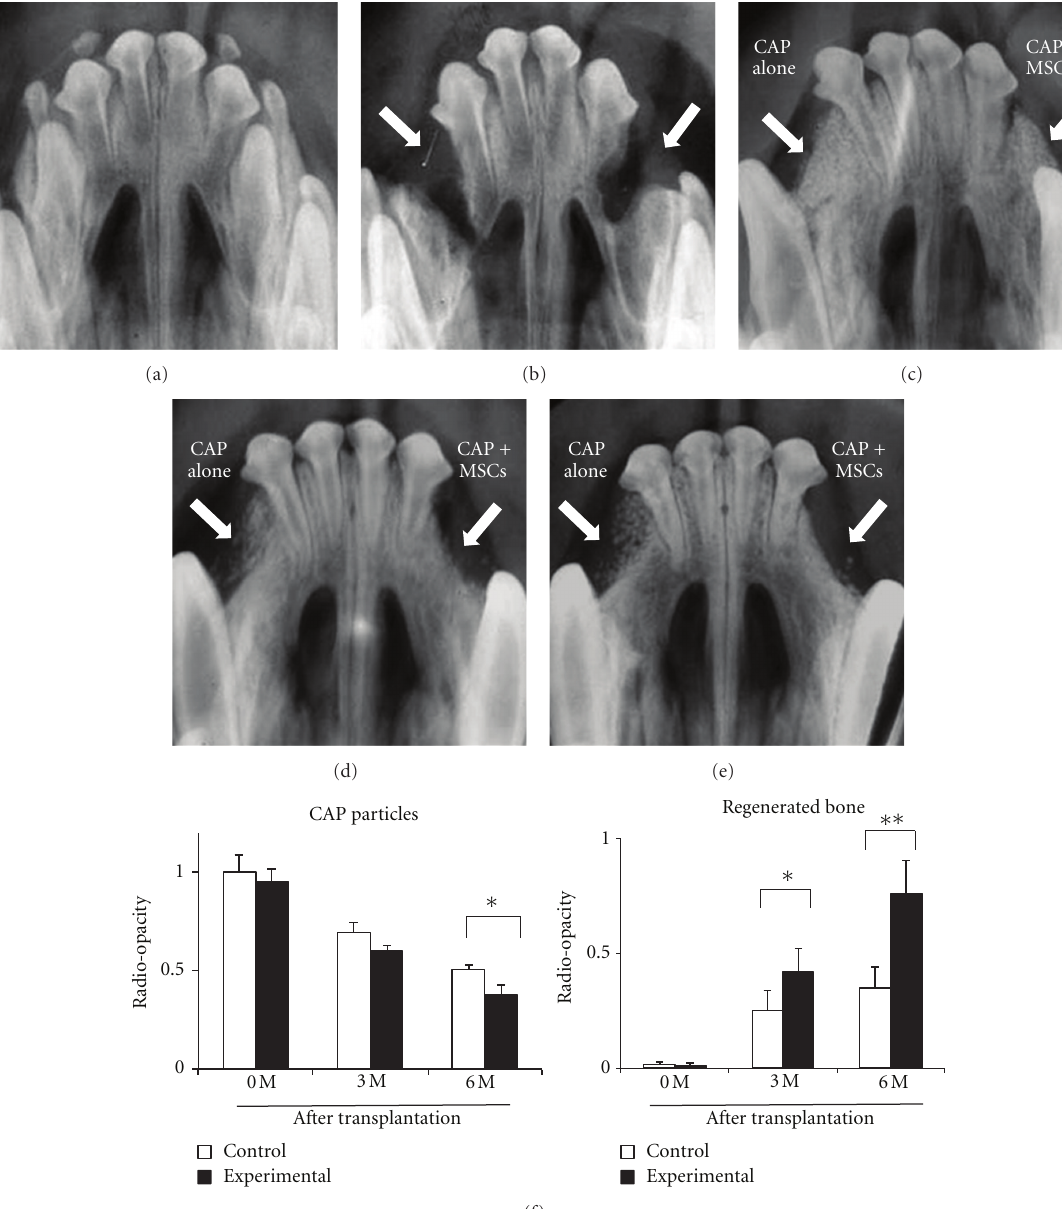
Figure 3: Radiographic findings before and after the transplantation of MSCs to artificial jaw cleft. Standardized occlusal X-ray images (a) after preparation of bilateral artificial jaw cleft in maxilla, (b) before and (c) after transplantation of MSCs with CAP particles to the jaw cleft (3 months after the preparation of artificial jaw cleft; arrowhead, jaw cleft). The cleft on the right side (control side) was filled with CAP particles alone, whereas the cleft on the left side (experimental side) was filled with MSCs and CAP particles, (d) 3 months and (e) 6 months after the transplantation (arrowhead, transplanted area). (f) The radio-opacity of the artificial jaw cleft area was measured on the standardized occlusal X-ray images after the transplantation to the artificial jaw cleft. The signals of regenerated bone and CAP particles were evaluated by radio-opacity of the jaw cleft area . N = 3, ∗ P < 0 . 05, ∗∗ P < 0 .